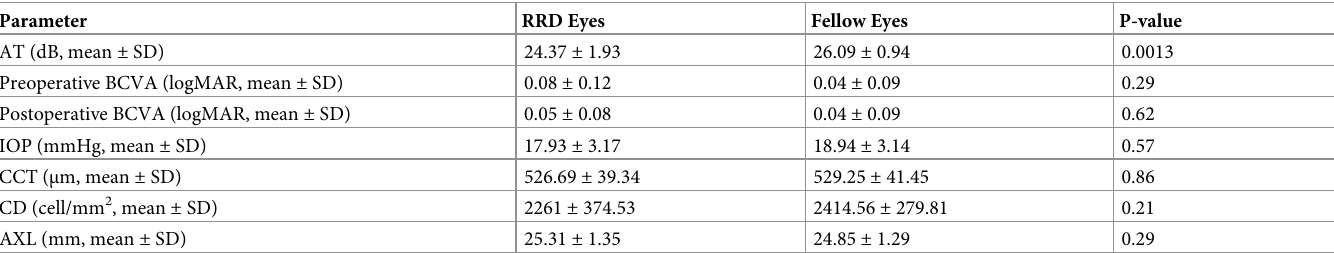
Table 2. Comparison of functional and morphological characteristics between fellow